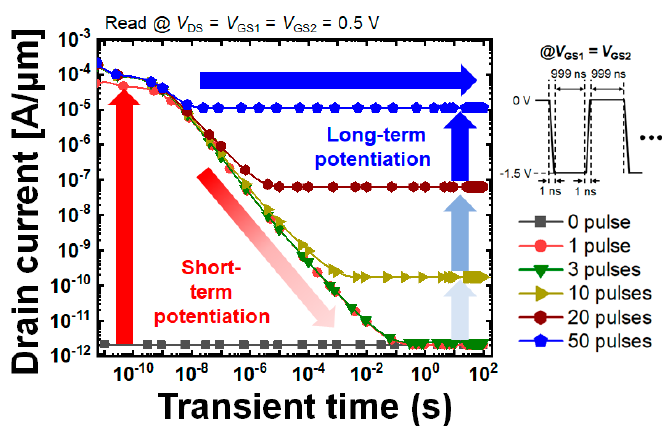
Figure 7. Retention characteristics under a constant read bias condition, V GS1 = V GS2 = V DS = 0.5 V after potentiating operations with different numbers of potentiation pulses.